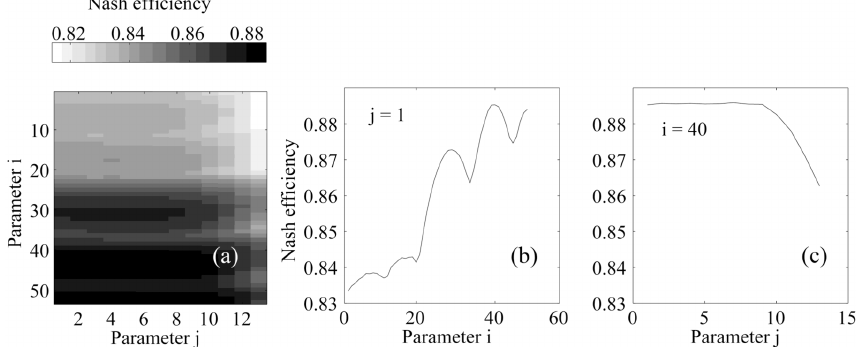
Fig. 5. Nash efficiencies for the TRG algorithm in the Dongjiang River basin, (a) as function of i and j , (b) as function of i for j =1, and (c) as function of j for i =4.